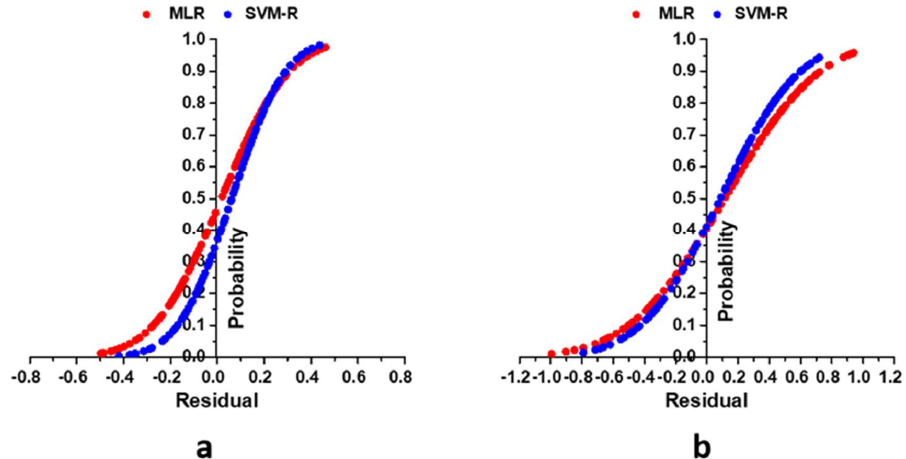
Figure 11. Cumulative distribution analysis using MLR and SVM-R models, ( a ) graph calculated from measured and predicted pH values ( b ) graph calculated from measured and predicted TSS content data during the testing period.